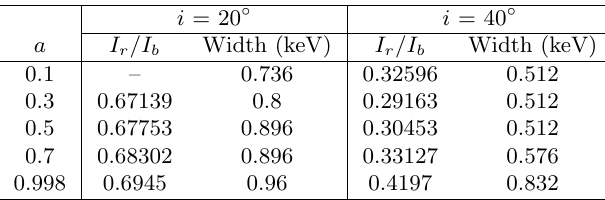
Table 1. The ratios between the red and blue peak intensities ( I r =I b ) and widths at half of the blue peak intensity in the case of the simulated Fe K (cid:11) line profiles from Figure 2. The results are given for five different values of the black hole spin, a , and for two disk inclinations: i = 20 ◦ and 40 ◦